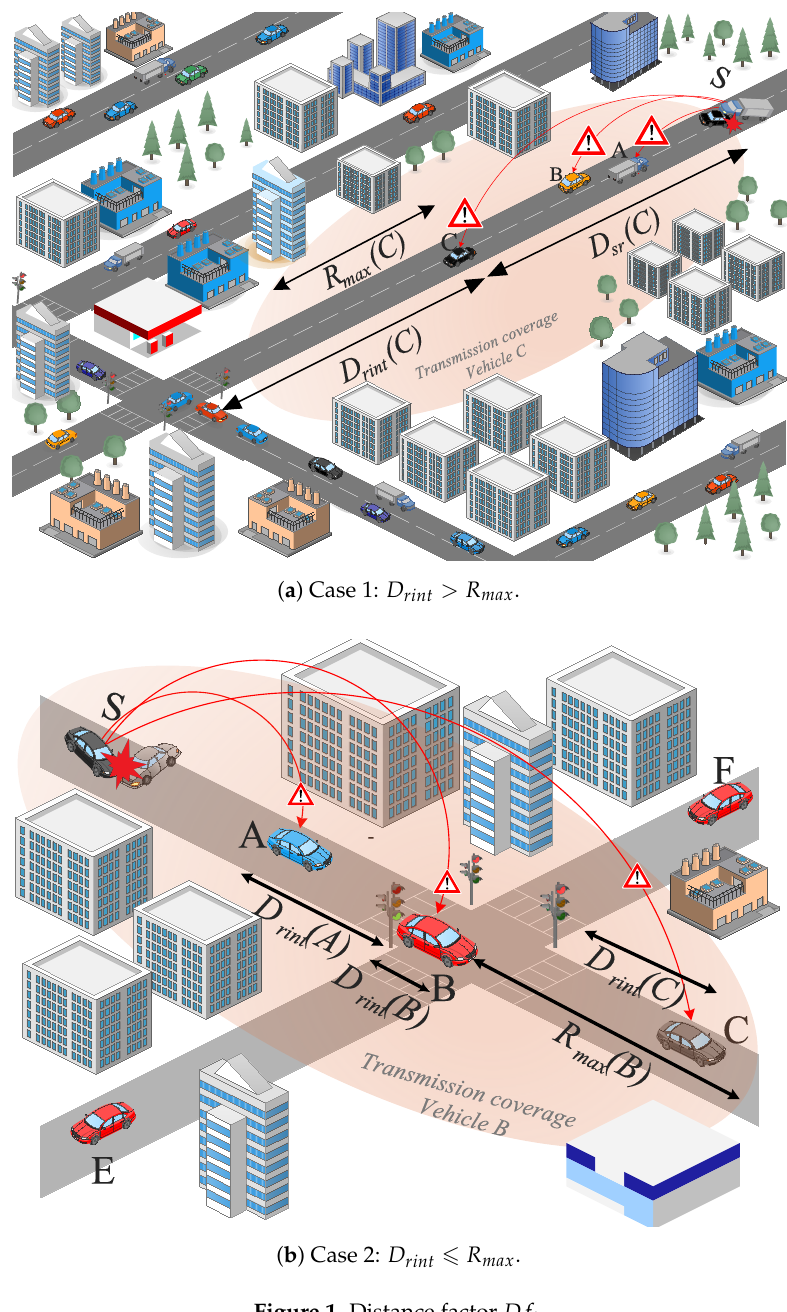
( b ) Case 2: D rint (cid:54) R max . Figure 1. Distance factor Df i